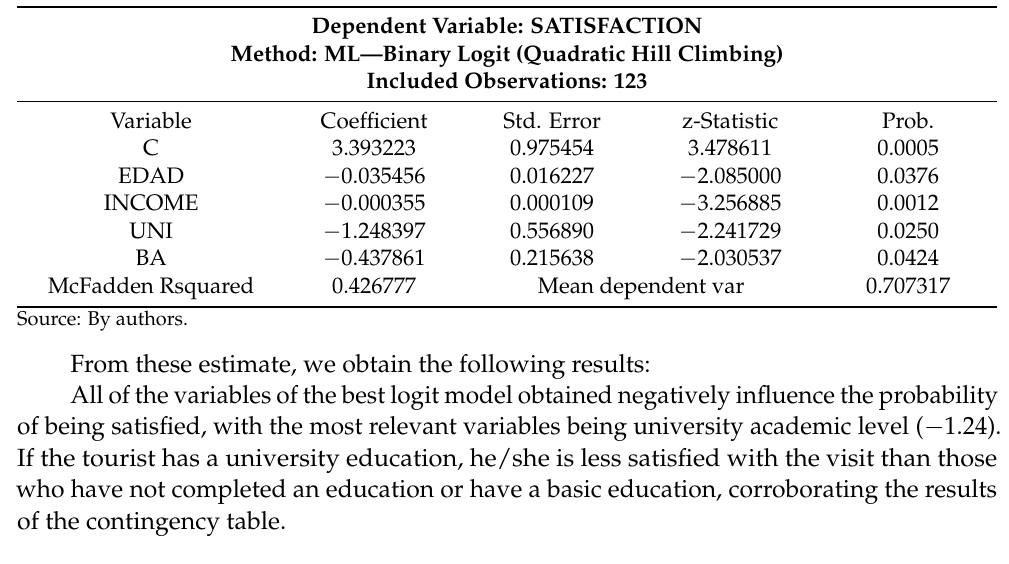
Table 7. Estimation logit